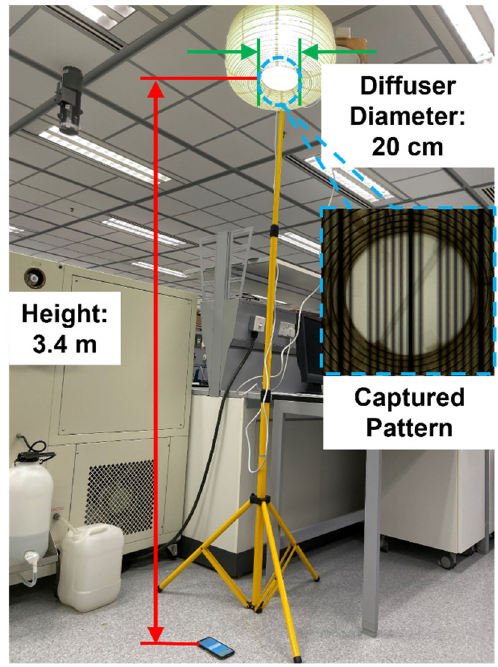
Figure 8. Experiment setup for measuring the VLC link distance.